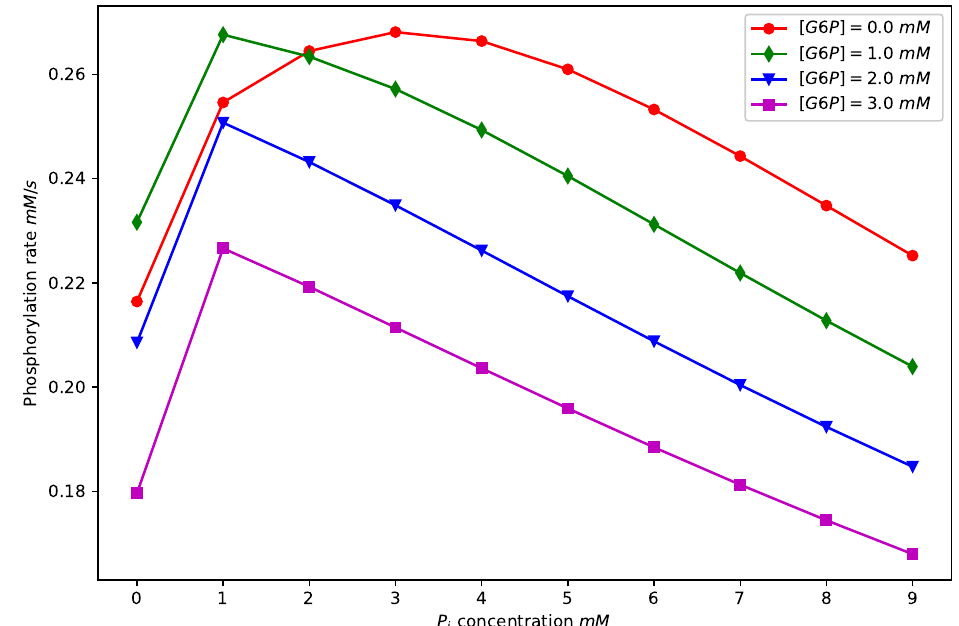
Figure 9. Plots of the phosphorylation rate as a function of the initial concentration of phosphate P i and for four different initial concentrations of G 6 P . The parameter values used to generate these curves can be found in Tables 2 and 3. We note an initial increase in the phosphorylation rate in all cases, followed by a subsequent decrease in the rate. This is discussed further in the main